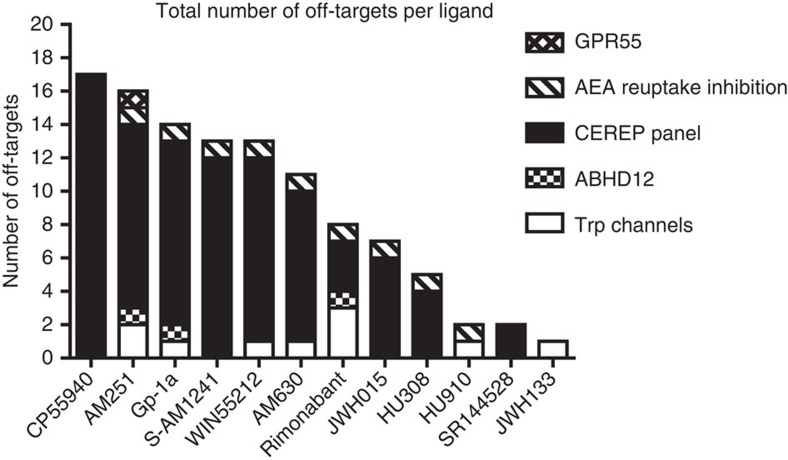
Summary of off-target activity.Summary of the total amount of off-targets per reference ligand. CP55940 is the most nonselective one with 17 off-targets, whereas JWH133 seems to be the most selective of the available agonists. Of the antagonists, SR144528 seems to be the most selective ligand. Off-target activity in the CEREP panel, on serine hydrolases, or on AEA reuptake inhibition is defined as >50% difference in effect compared to basal levels at a concentration of 10 μM and/or a submicromolar potency on the given off-target.